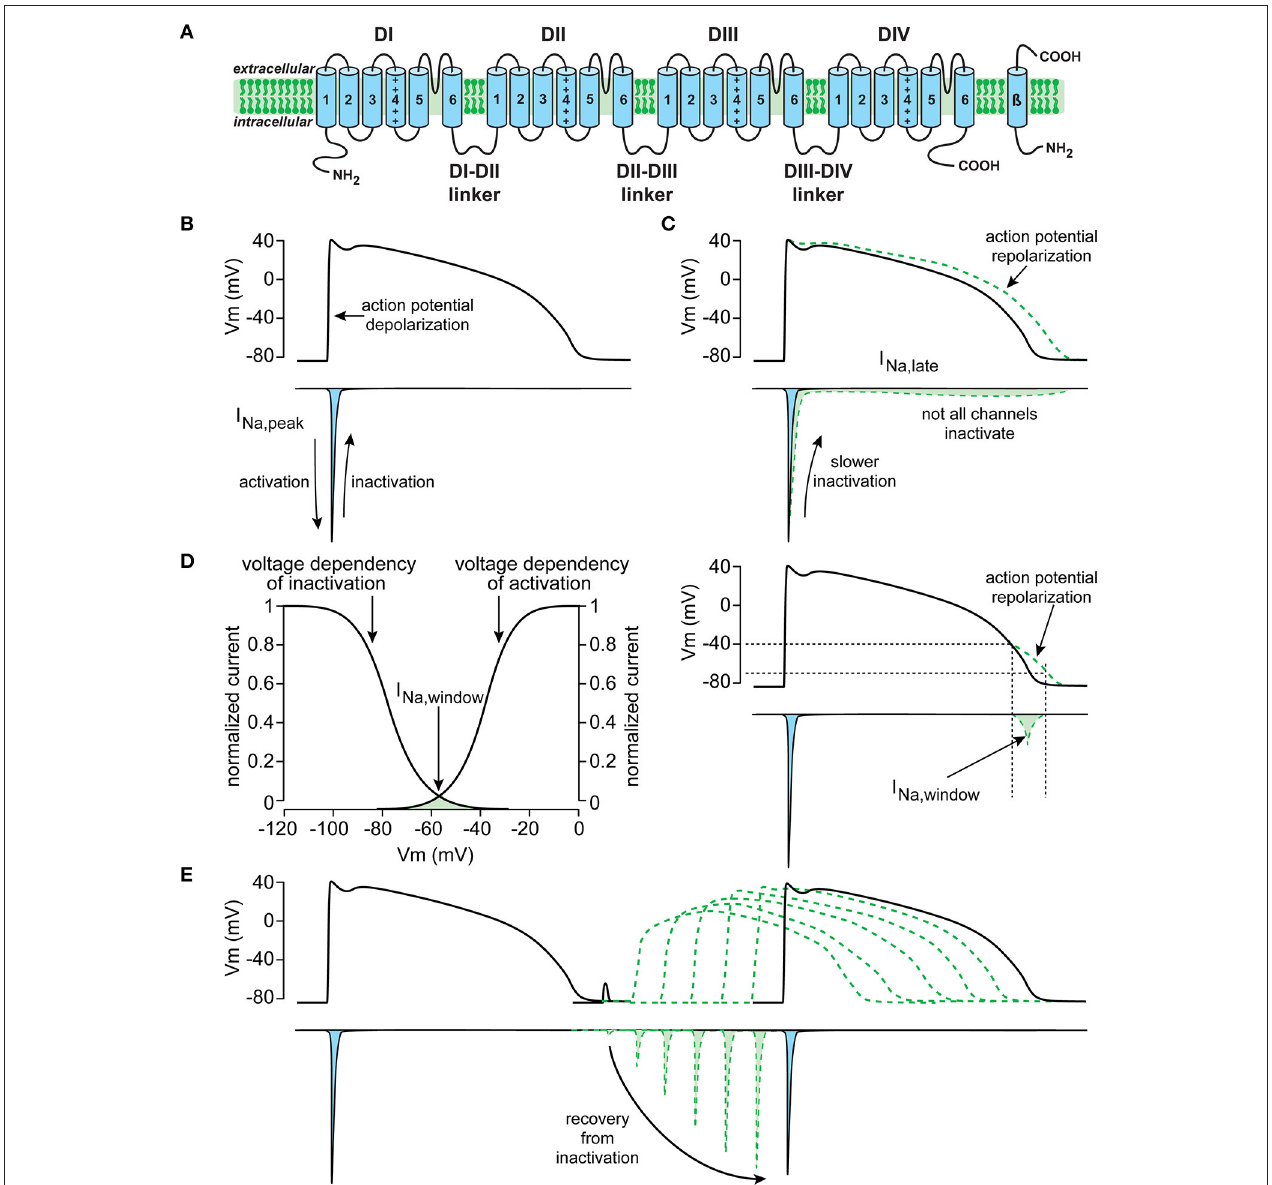
FIGURE 1 | Schematic drawings of the cardiac sodium channel Na V 1.5 encoded by the SCN5A gene (A) , and important biophysiological properties and function of the current generated by SCN5A (here named I Na ), including peak I Na (B) , late I Na (C) , window I Na (D) , and recovery from inactivation (E)